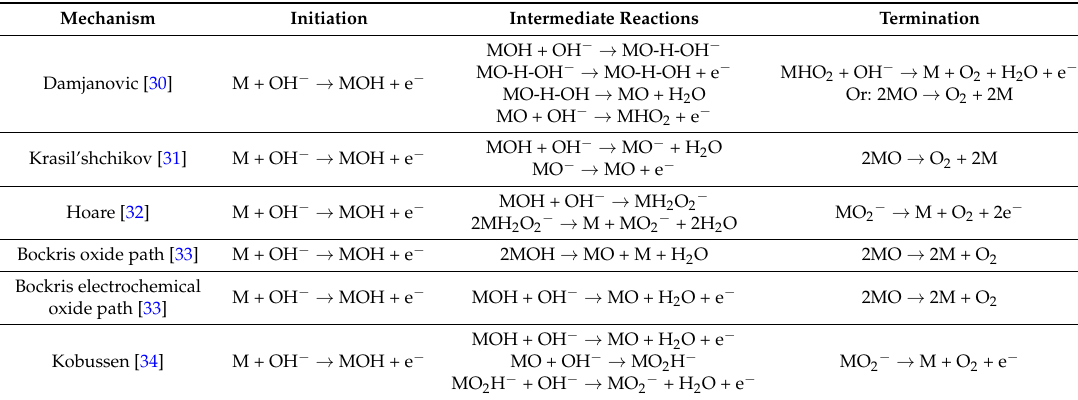
Table 1. Proposed mechanisms of the oxygen evolution